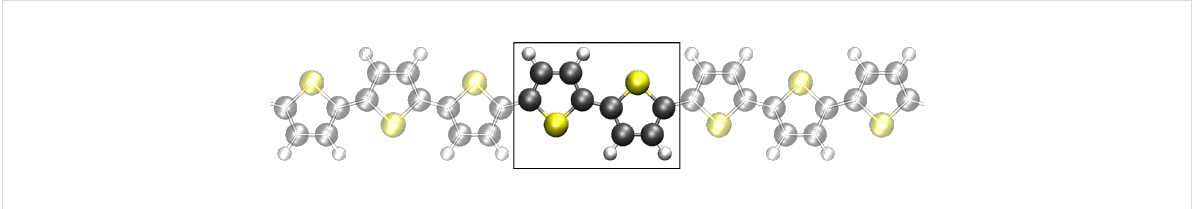
Figure 1: Considered structure of polythiophene (PTp). The frame indicates the unit cell used in the calculations, which contained two thiophene rings connected at their respective α -positions.